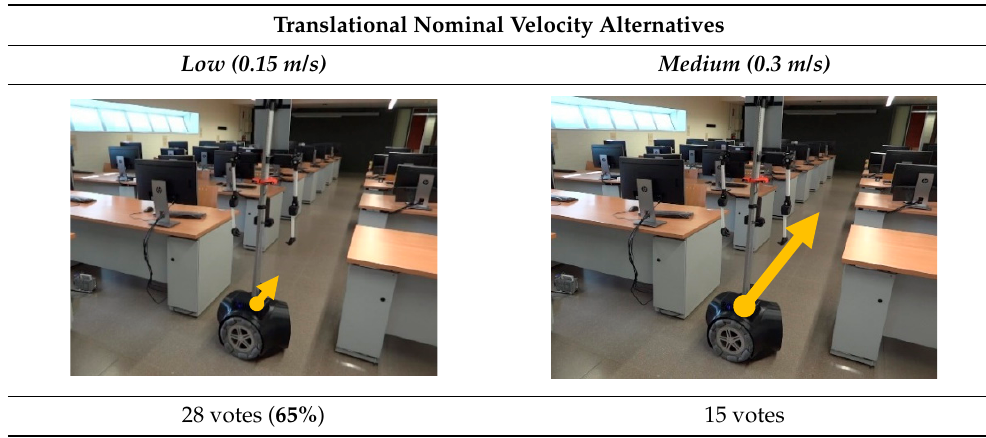
Table 12. Alternatives considered to define the translational nominal velocity and votes received.